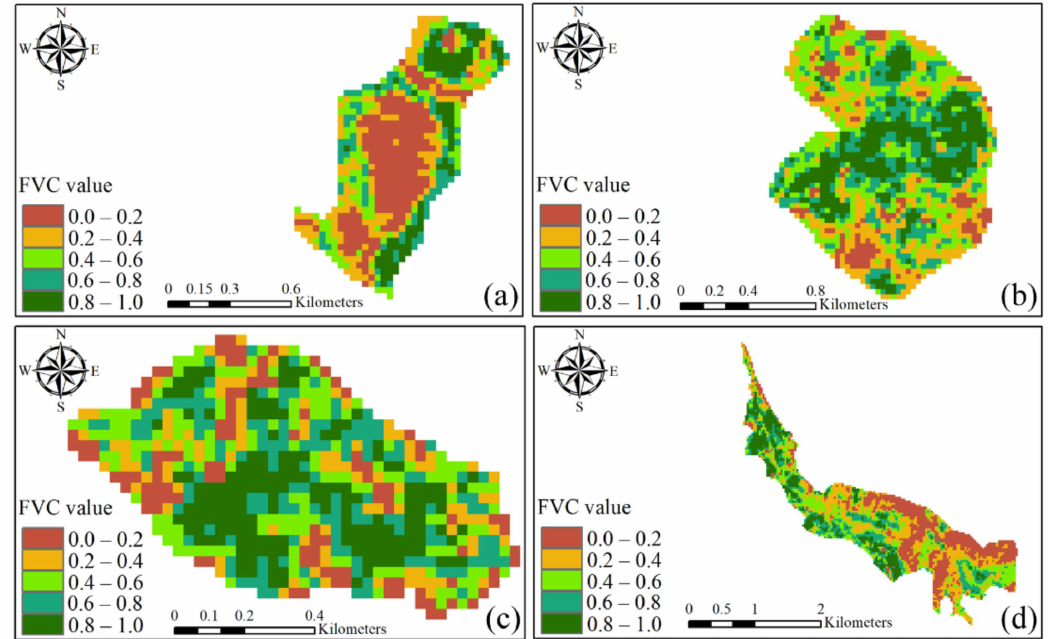
Figure 2. Spatial changes in the fractional vegetation cover (FVC) of the surveyed parks: ( a ) Jincheng Park; ( b ) Renshoushan Park; ( c ) Baitashan Park and; ( d ) Lanshan Park. The FVC of the surveyed parks also exhibited variations across elevation, in discrete patterns for each park. The FVC by altitude followed “U-shaped” (Jincheng Park), linear (Renshoushan Park), inverted “U-shaped” (Baitashan Park), and “N-shaped” (Lanshan Park) patterns. The highest FVC values also occurred at different altitudes in each park: at low altitude in Jincheng (1582–1600 m above sea level; FVC 59%); at mid-to-high altitude (1651–1675 m above sea level) in Renshoushan (FVC 67%) and Baitashan (FVC 66%); and at high altitude in Lanshan (2101–2125 m above sea level; FVC 79%); whereas the lowest values were recorded in the mid-to-high altitude in Jincheng (1651–1675 m above sea level; FVC 31%); at mid-to-low altitude in Renshoushan (1601–1625 m above sea level; FVC 49%); and at low altitude (1536–1550 m above sea level) in Baitashan (FVC 18%)